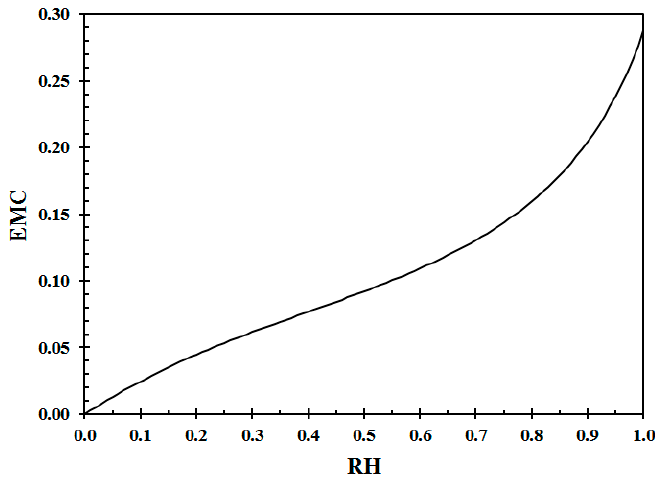
Figure 2. Wood Equilibrium Moisture Content (EMC) at 22 °C (Calculation procedure given in [37]).